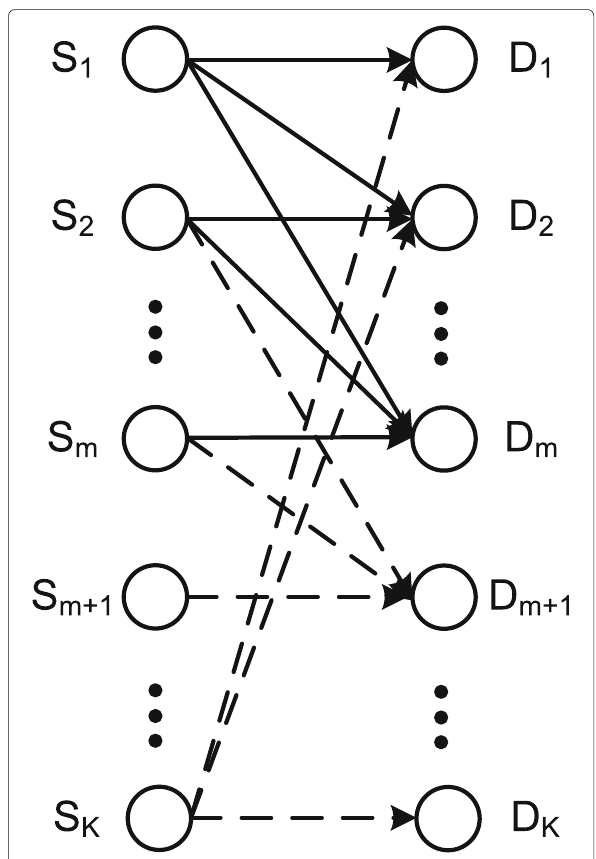
Fig. 9 Channel gain assignment in a single-layer ( K , m ) folded-chain network. All solidlinks have capacity n (for the linear deterministic model) and h (for the Gaussian model), and all dashedlinks have capacity